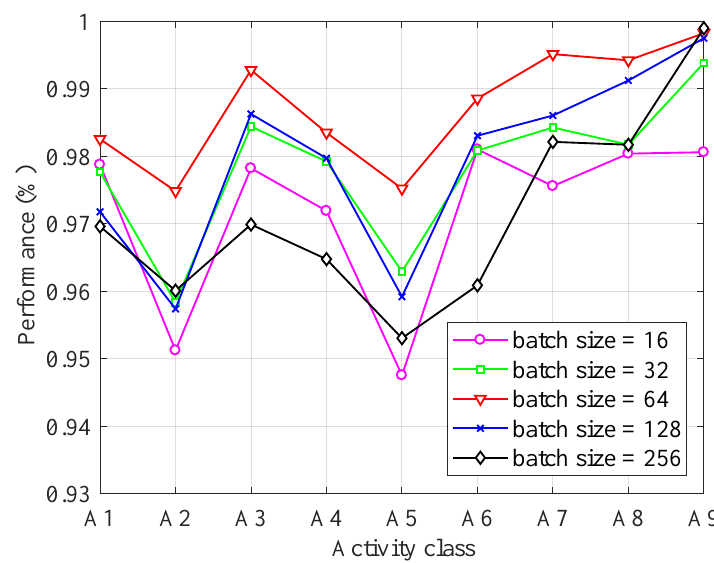
Figure 7. The performance with different batch size.